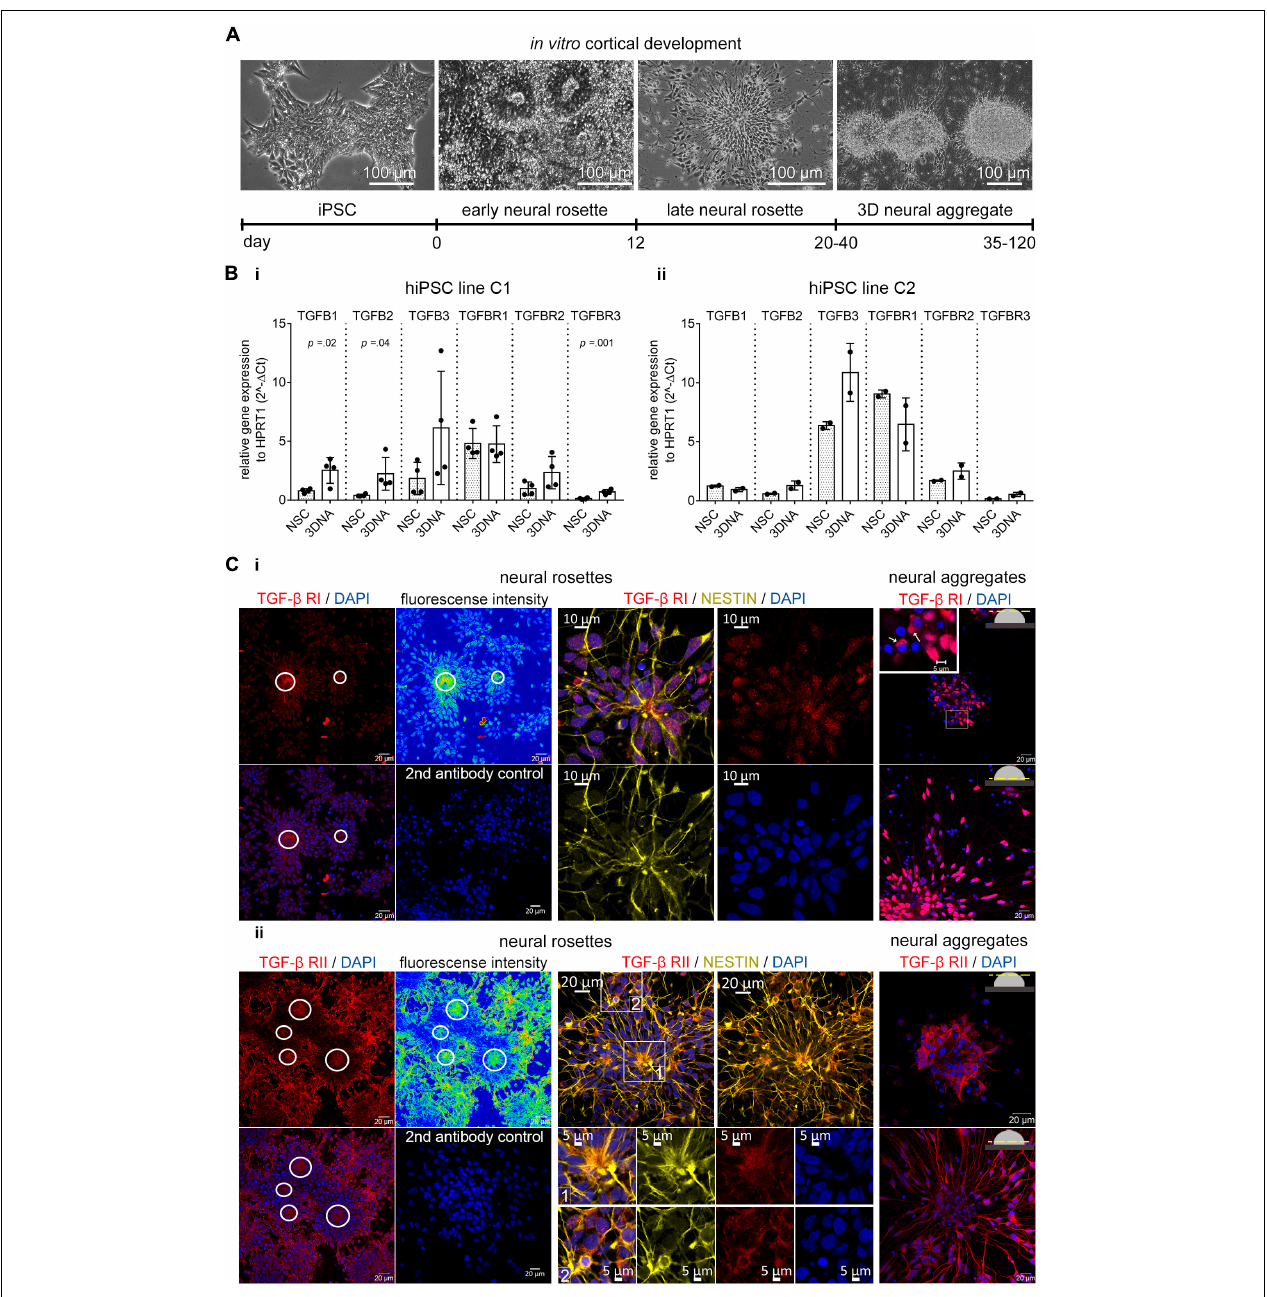
FIGURE 2 | TGF- β receptors and ligands in human iPSC-derived neural in vitro model. (A) Phase contrast images and related timeline show the in vitro cortical development from hiPSCs toward 3D neural aggregates. (B) Gene expression of TGFB ligands and receptors in human iPSC-derived neural rosette (NSC) and neural aggregate (3DNA) cultures in (i) hiPSC line C1 and (ii) hiPSC line C2. The data is presented as mean ± standard deviation, unpaired t -test was used to calculate the indicated p -values. N = 1–2/cell line, each dot represents the value from one technical replicate. (C) Confocal images of (i) TGF- β 1 RI and (ii) RII in the NESTIN + cells in neural rosettes (left) and in the neural aggregates (right). Color coded fluorescent density images and circles highlight the accumulation of TGF- β receptors at the luminal side of neural rosettes. The secondary antibody control images are also shown (2nd antibody control). Insets highlight the cytoplasmic localization of TGF- β RI and